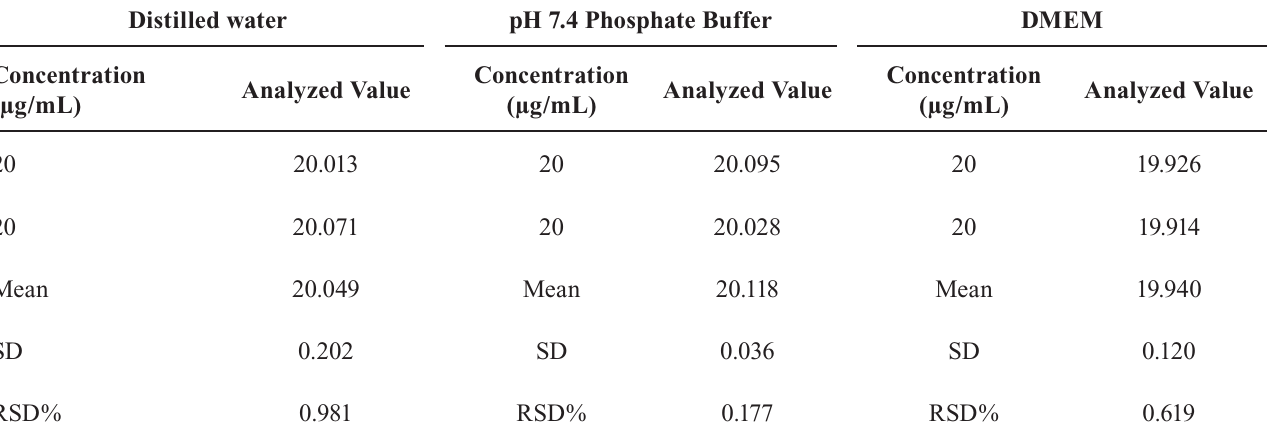
Distilled water